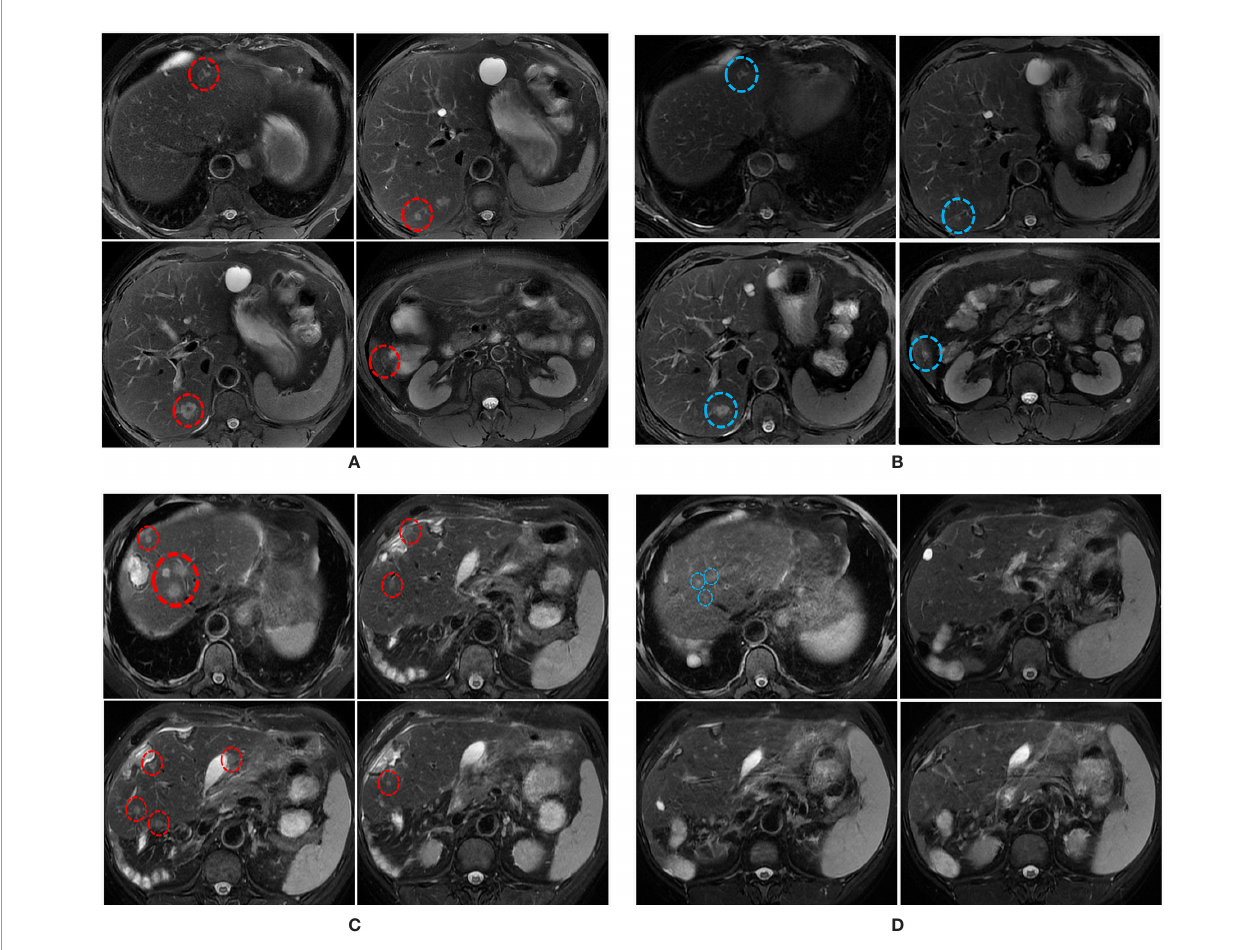
FIGURE 2 | MRI scans illustrating the changes in liver metastatic tumors over time. (A) MRI scans on the 30 th of December 2019 shows multiple liver metastases (red circles). (B) MRI scans on the 7 th of March 2020 shows the size of some liver metastases was reduced (blue circles) following the combination treatment. (C) MRI scans on the 16 th of April 2020 shows multiple liver metastases (red circles). (D) MRI scans on the 28 th of June 2020 shows the sizes and numbers of liver metastasis were signi fi cantly reduced following the combined